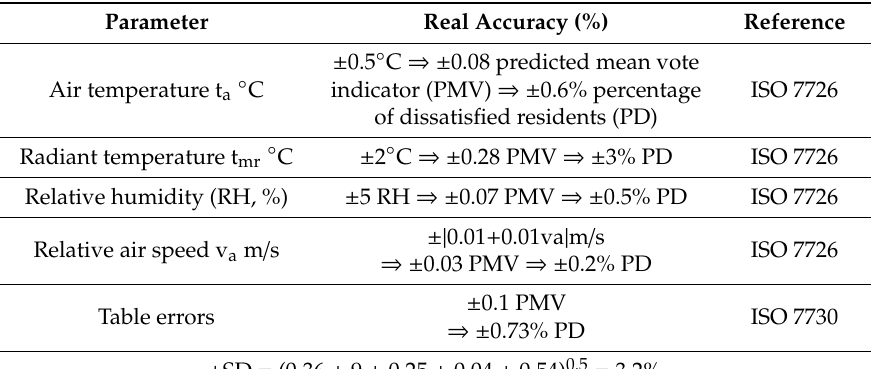
Table 6. Realistic measurement uncertainty of PD TC